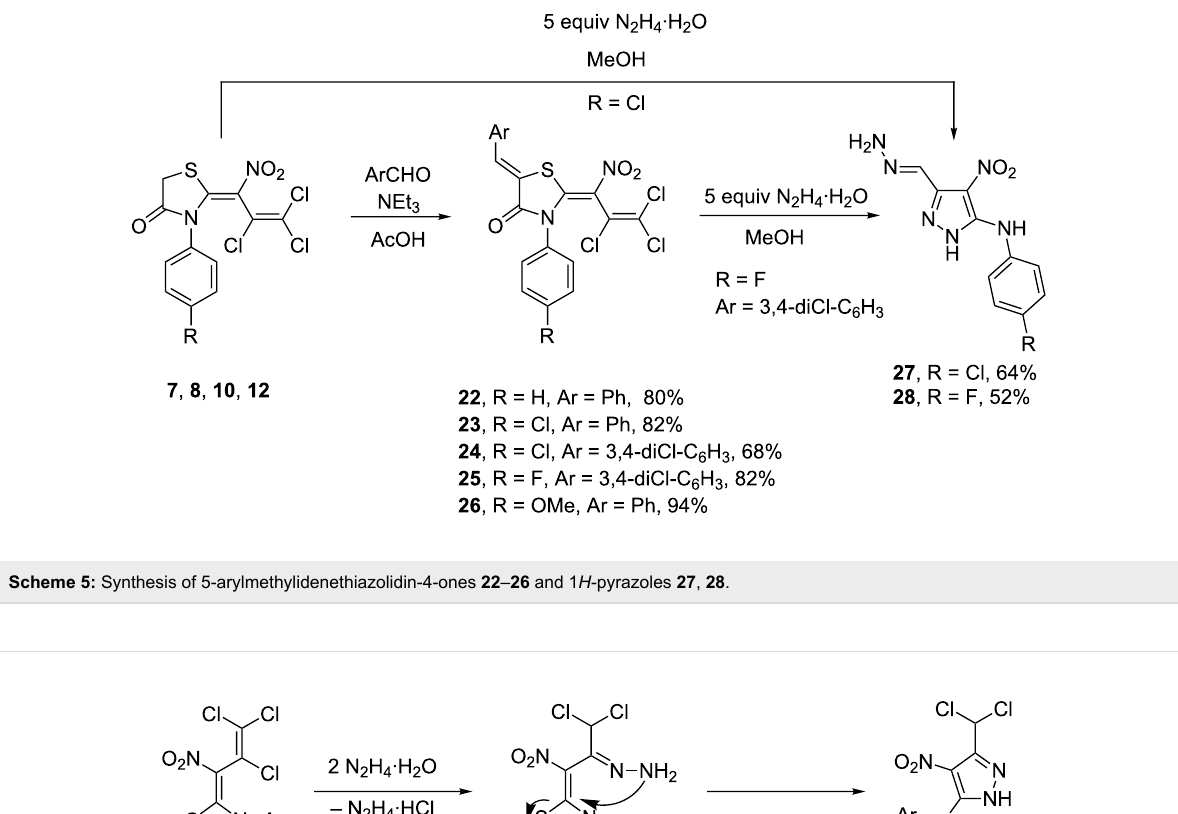
Scheme 6: Assumed mechanism for the formation of 1 H -pyrazole 27